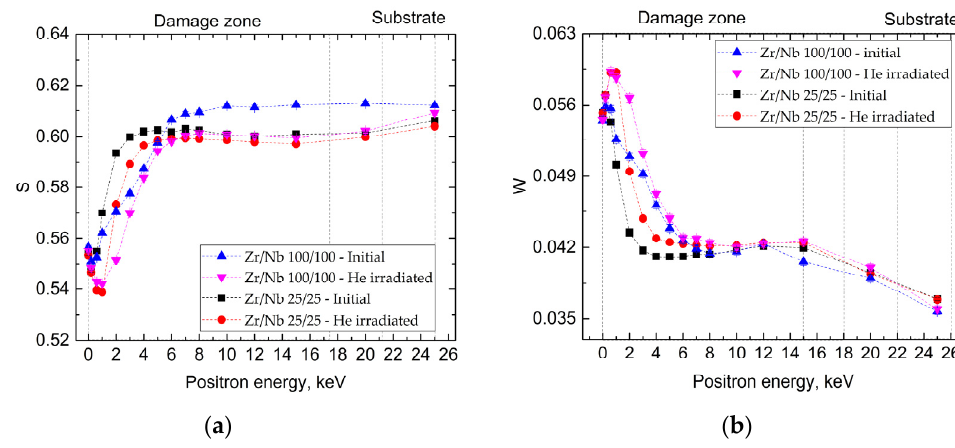
Figure 2. Dependence of the S ( a ) and W ( b ) parameters on the positron energy for Zr/Nb NMCs before and after helium ion